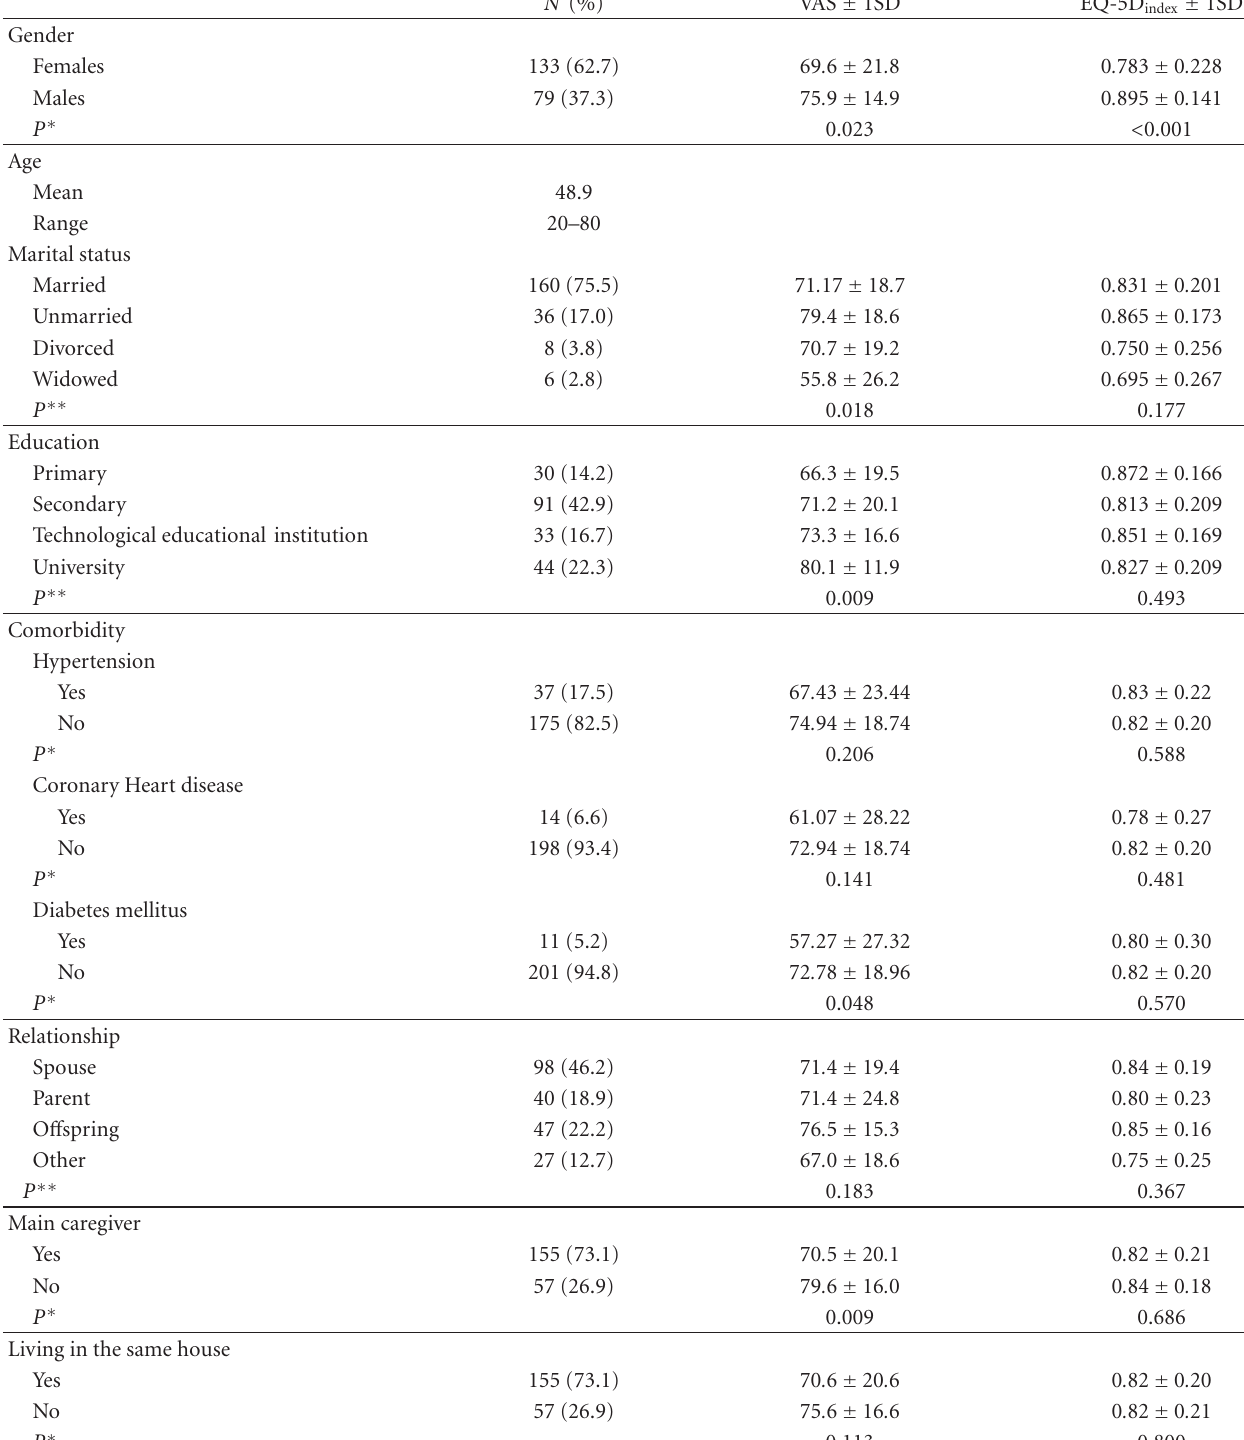
Table 2: Caregivers’ sociodemographic and clinical characteristics, EQ-5D VAS, and Index